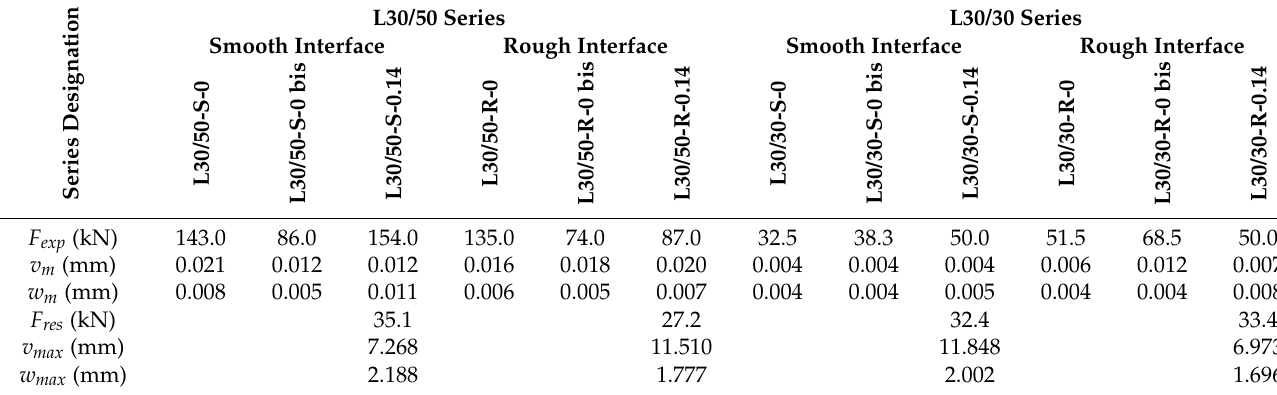
Table 8. Load carrying capacities and corresponding deformation characteristics.